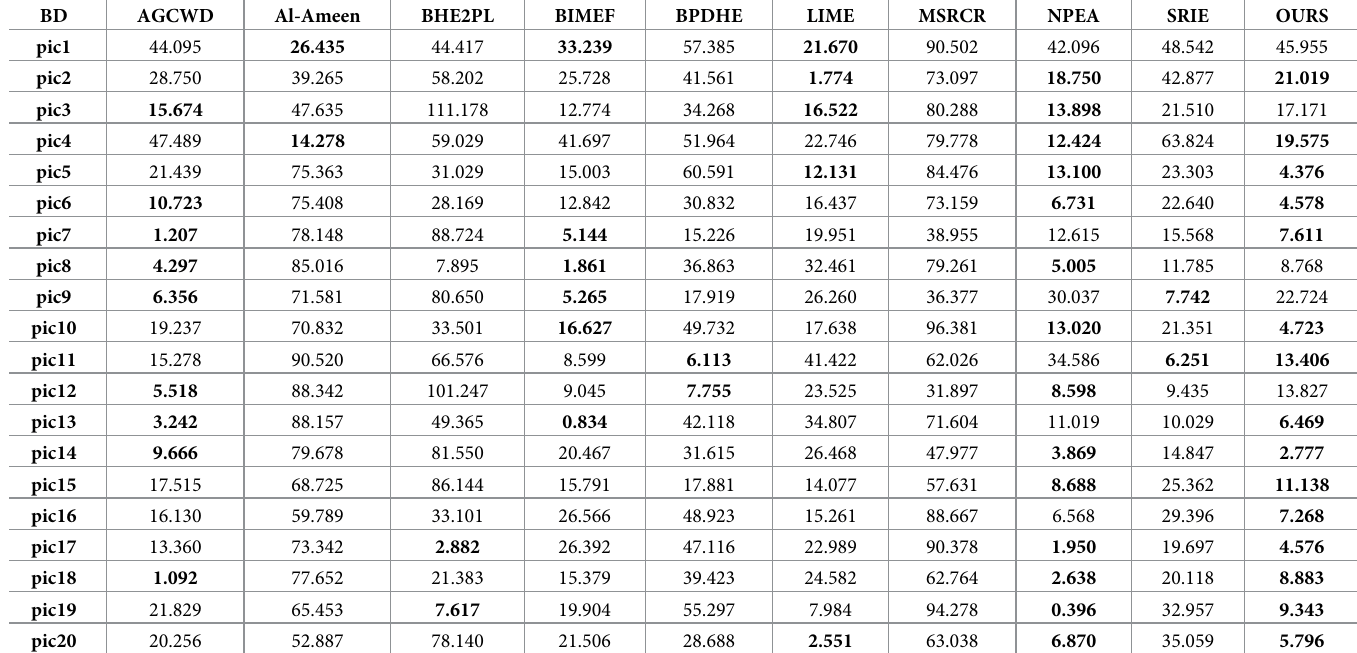
Table 13. Image brightness difference values of 20 random images of MIT-5K.